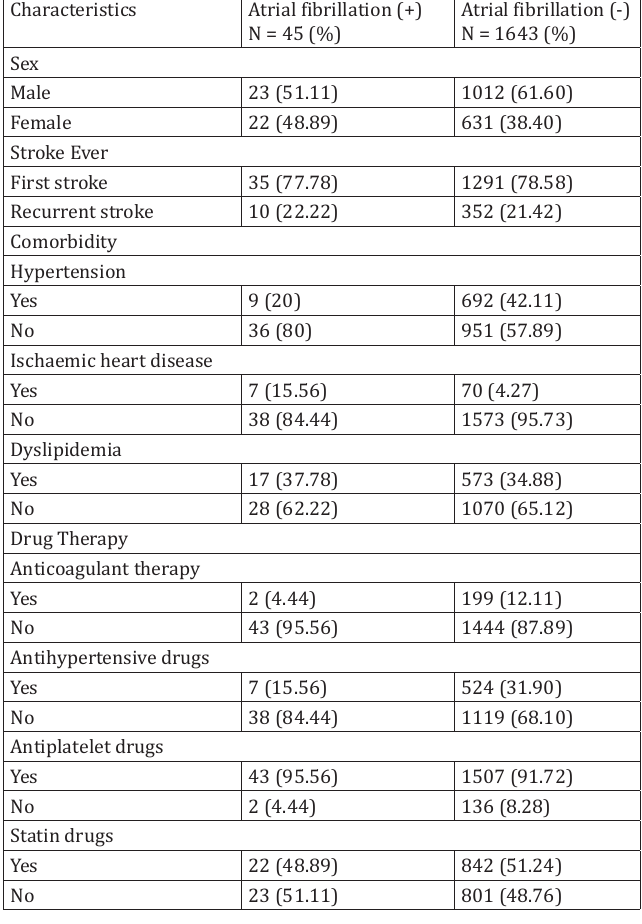
Characteristics